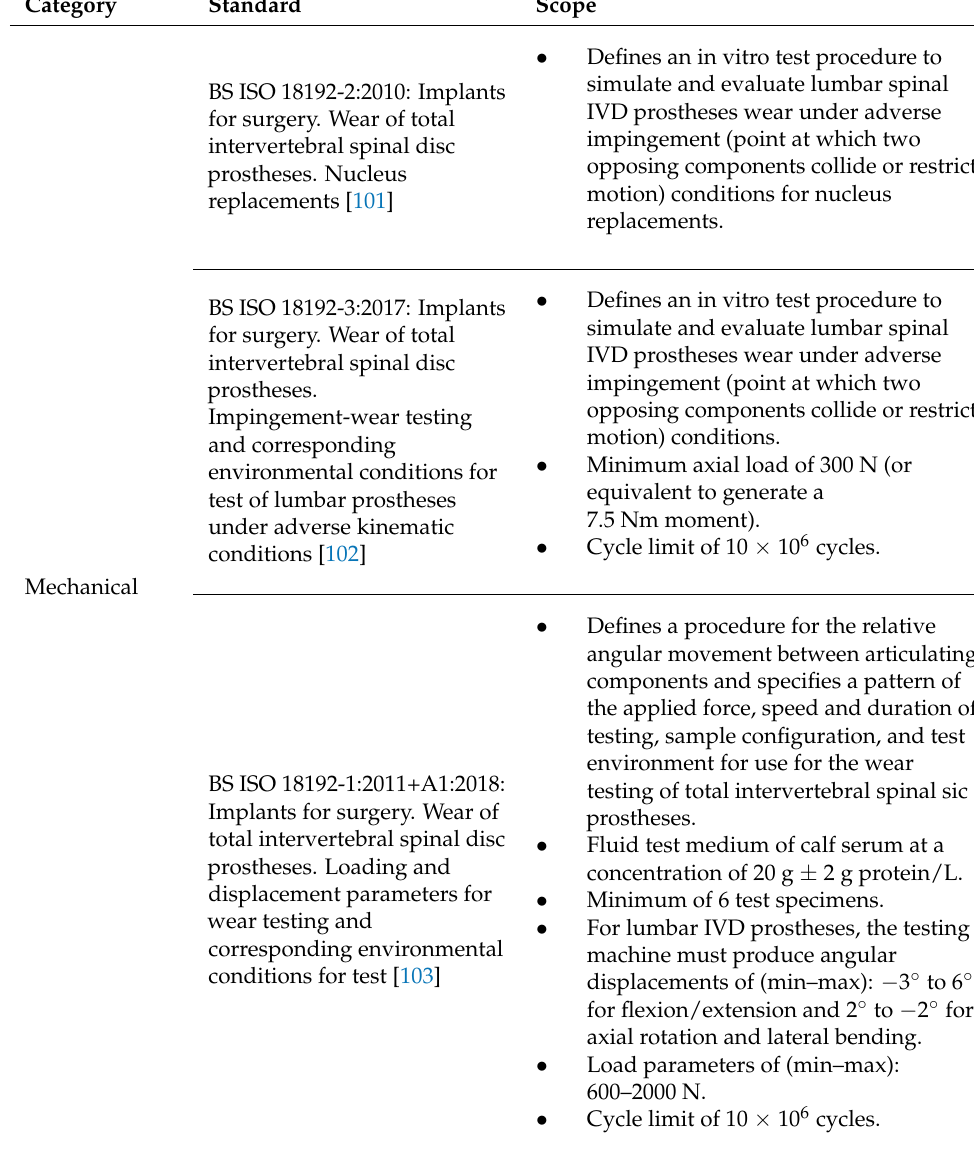
Table 3. Relevant standards and recommendations for